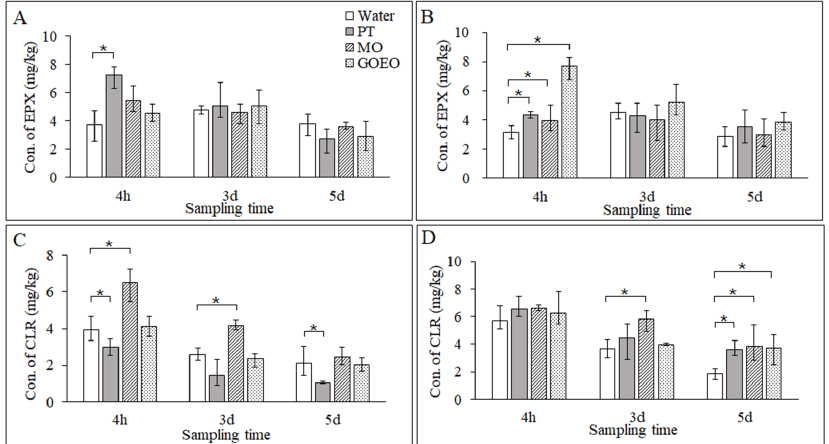
Figure 3. The deposition concentrations of EPX and CLR on the leaf surface: ( A ) EPX at 125 mg/L, ( B ) EPX at 187 mg/L, ( C ) CLR at 66.7 mg/L, and ( D ) CLR at 100 mg/L. * p < 0.05.